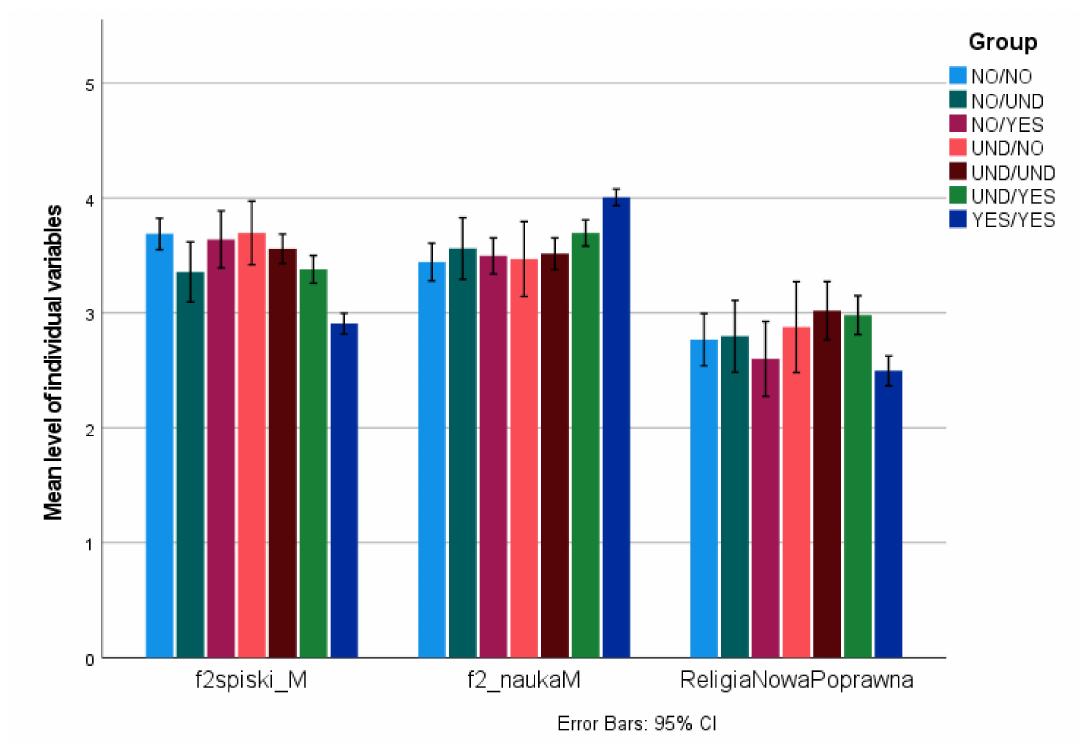
Figure 3. Individual differences and consistency between declared and actual vaccination against